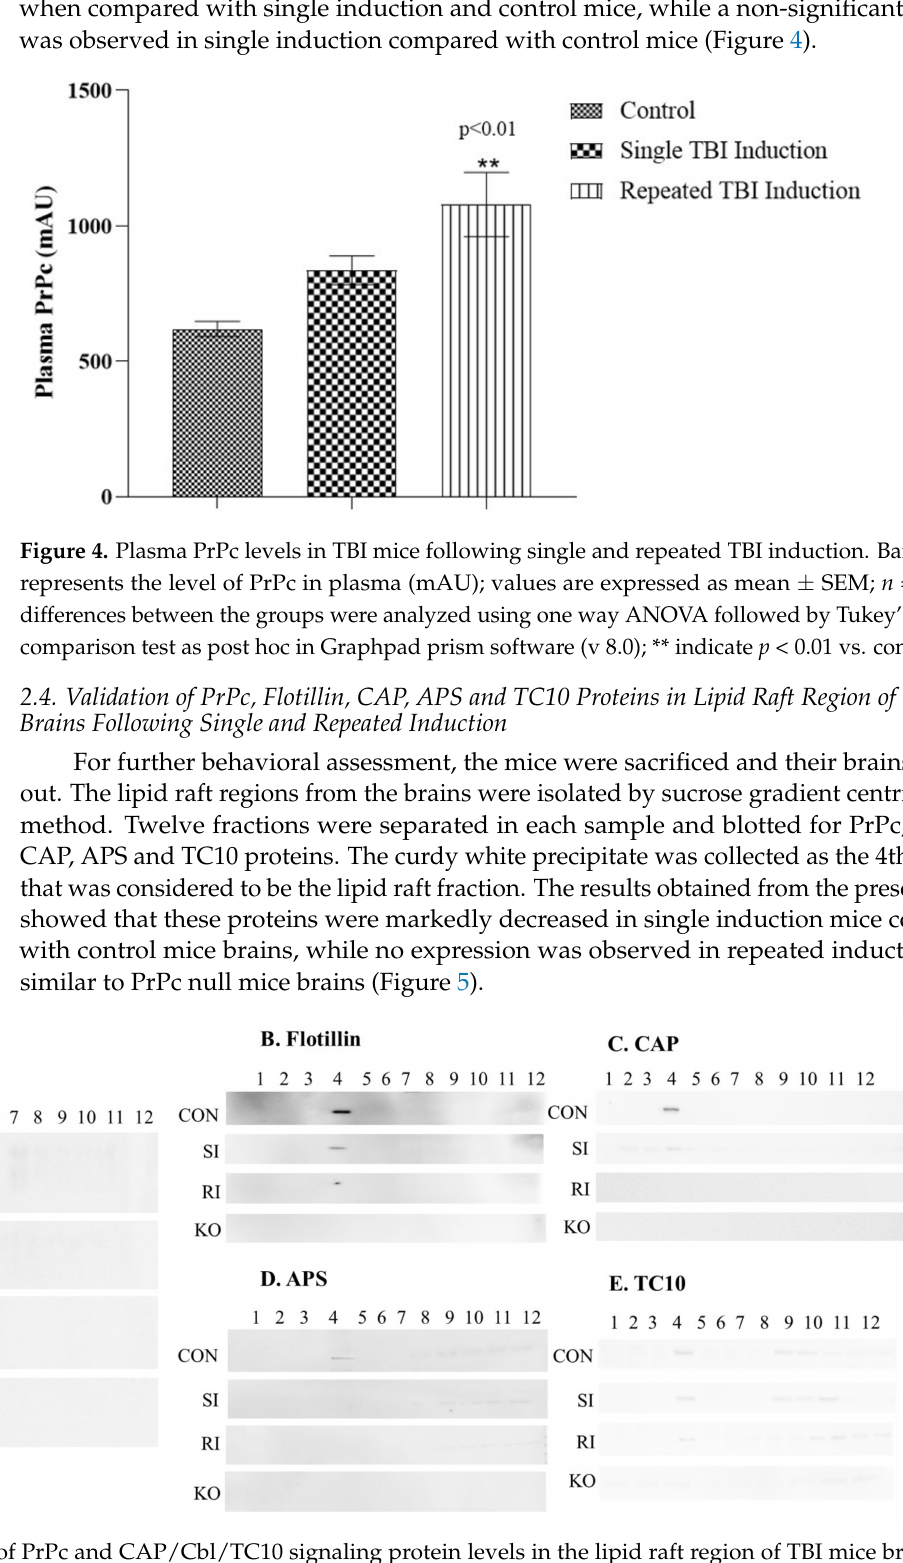
Figure 5. Determination of PrPc and CAP/Cbl/TC10 signaling protein levels in the lipid raft region of TBI mice brains. Levels of PrPc ( A ), flotillin ( B ), CAP ( C ), APS ( D ) and TC10 ( E ) in lipid raft regions of control, single and repeated TBI induced mice, and PrPc null mice brains were measured using lipid raft isolation followed by Western blotting technique ( n = 3). CON—control; SI—single induction; RI—repeated induction; KO—PrPc null mice